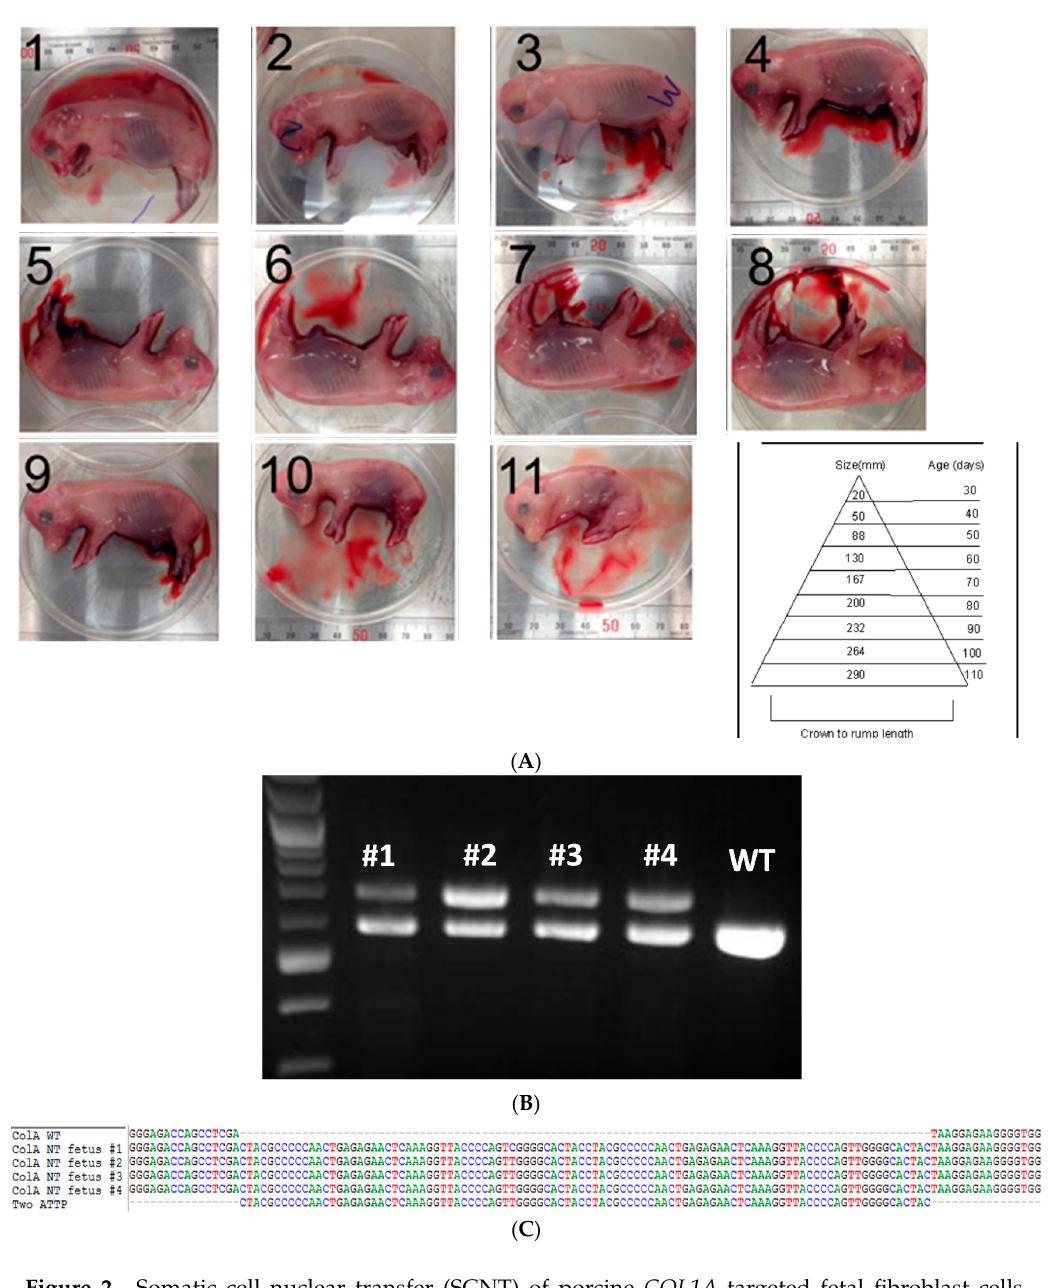
Figure 2. Somatic cell nuclear transfer (SCNT) of porcine COL1A targeted fetal fibroblast cells. ( A ) Photomicrograph depicts 11 clonal fetuses (numbered 1–11) at Day 45 of pregnancy along with a chart depicting crown-rump length and age of the fetus measure is shown; ( B ) Agarose gel electrophoresis image of COL1A amplicons from fetuses (numbered 1–4) on the top showing targeted knockin of the two attP sites and a 100 bp shift in size. Amplicon from wildtype (WT) animal is shown as a reference; ( C ) Sanger sequencing of the clonal lines confirming the inclusion of the target sites. Multiple sequence alignment of wild type (WT) COL1A gene and two pseudo attP knockin sites are shown. Each nucleotide is color